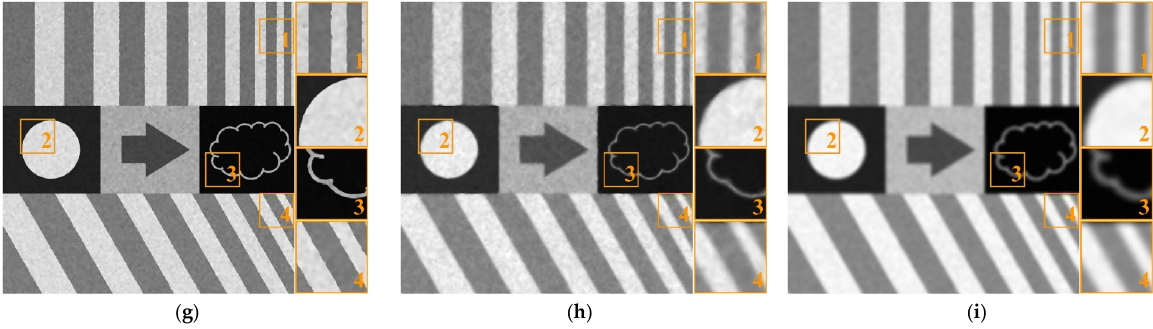
Figure 11. Experimental results on the synthetic image: ( a ) is the original image, and ( b – i ) are filtered results of our method, Lee filter, traditional Frost filter, SRAD, NLM, RGF,